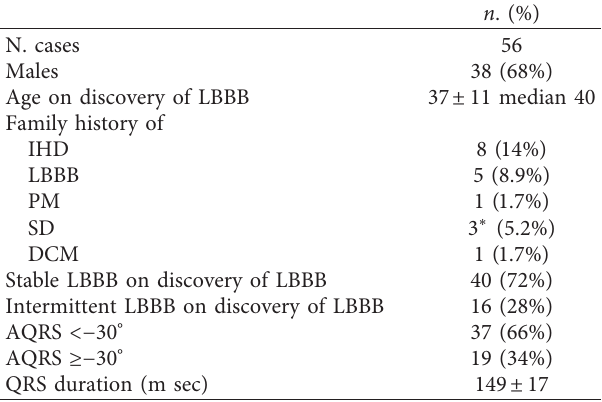
Table 1: Baseline characteristics of patients: yrs � years; IHD � ischemic heart disease; PM � pacemaker; SD � sudden death; DCM � dilated cardiomyopathy; ∗ patients also with familial IHD or LBBB.